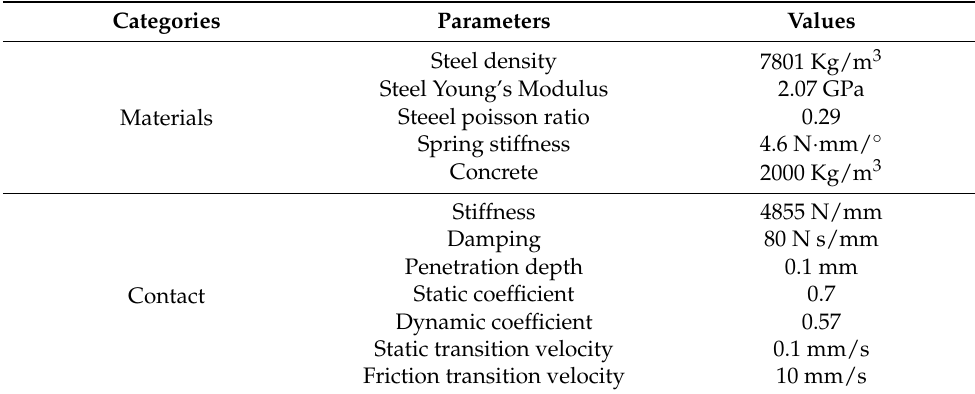
Figure 9. Variations in the center of mass for five walking cycles. 4.3. Grasping Simulation The foot toes initially rest in a relaxed open state, and will bend downward by the driven torques. Figure 10 shows the simulation results, in which the red curves are the trajectories for the bending motion. The maximum rotation angle ( θ ) of the toes is about 120°, which is expected based on the structure and geometric sizes. However, in practice, the bending angles are highly affected by the stiffness of the contact surface. Figure 10. Grasping behavior simulation: ( a ) retrieving state and ( b ) grasping state. 5. Experimental Tests In accordance with the dimensions of the structure model in Figure 2, a prototype of the biomimetic robot was fabricated. Using a simulated test bed, the grasping behaviors